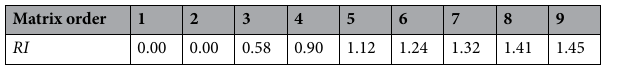
Table 1. Average random consistency